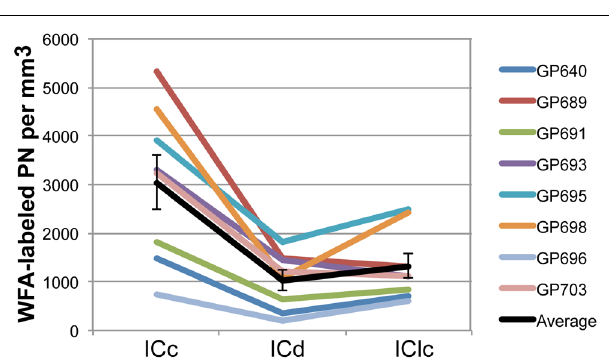
from low density in case GP689, to intermediate level in case GP693, and high density in case GP695.Transverse plane; medial is right, dorsal is up. Scale bars = 1 mm.